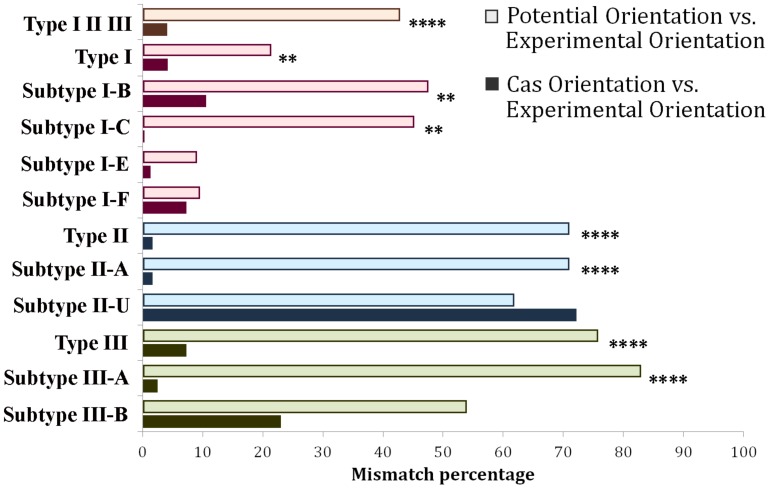
Distribution of mismatches between Potential Orientation vs. ND Experimental Orientation Set (lighter shade bar plots) and Cas Orientation vs. ND Experimental Orientation Set (darker shade bar plots) across different CRISPR/Cas types and subtypes. Every CRISPR/Cas type (along with corresponding subtypes) was denoted with a different color, red corresponding to Type I, blue to Type II, and green to Type III systems. The entire dataset (Type I, Type II, and Type III) was denoted with an orange bar plot. (∗P < 0.05; ∗∗P < 0.01; ∗∗∗P < 0.001; ∗∗∗∗P < 0.0001). Subtypes I-A, I-D, and II-B were omitted from the figure, due to the very small pool of analyzed arrays (5, 1, and 0, respectively). Note that II-U in the figure (labeled in accordance with CRISPRCasFinder notation), in fact corresponds to the subtype II-C.